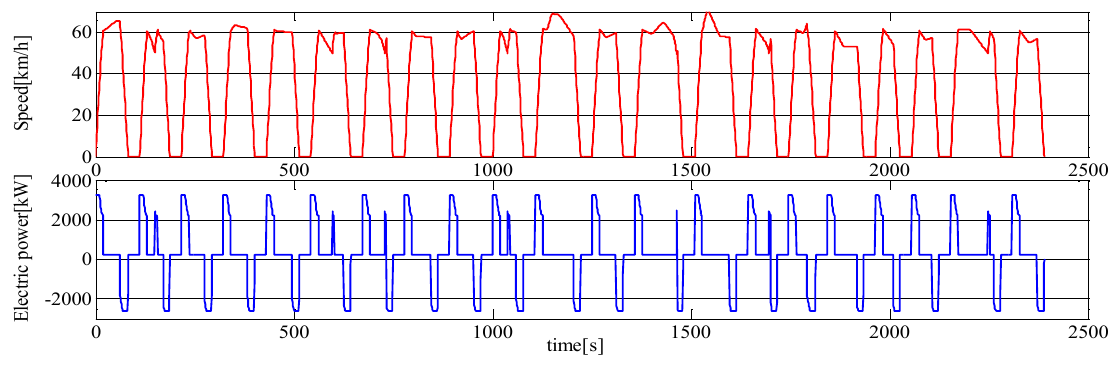
Figure10. The pantograph voltage and current of up-line